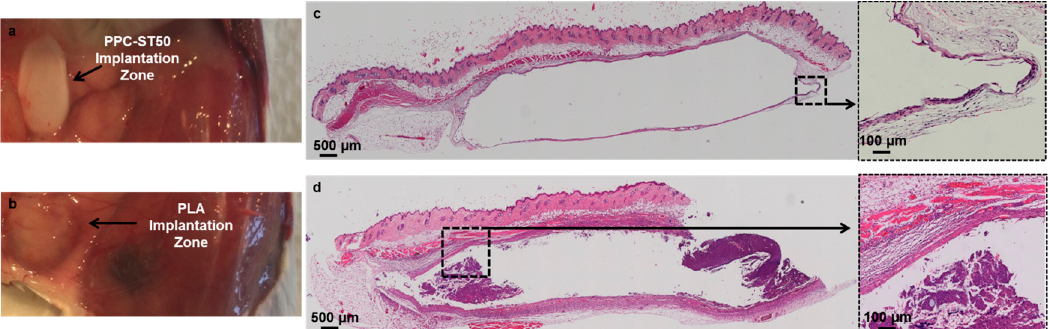
Figure 1. The explanation site of PPC-ST50 ( a ) and polylactic acid (PLA) ( b ) eight weeks post-surgery, and haematoxylin and eosin staining of paraffin sections of the implantation site at eight weeks around PPC-ST50 composite ( c ) and PLA ( d ). After eight weeks, a prominent foreign body reaction could be observed in the PLA implantation zone. However, the inflammatory response to the PPC-ST50 composite resolved dramatically. The PPC-ST50 and PLA scaffolds are present in the H&E images may not adhere to the glass slides during histological staining. Figure reproduced with permission from [81]. Copyright (2015) American Chemical Society.